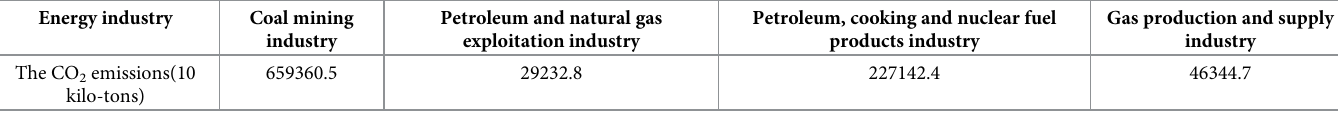
Table 5. Carbon emissions from the energy produced by four energy supply industries under baseline scenarios. Energy